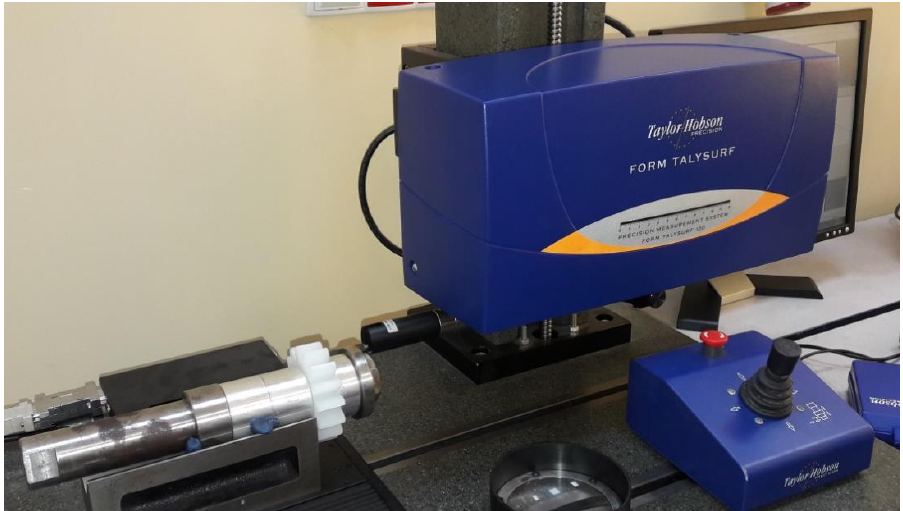
Figure 13. Surface roughness measurement along the longitudinal direction to the machining direction. Taylor Hobson contact profilometer, Talysurf 120.